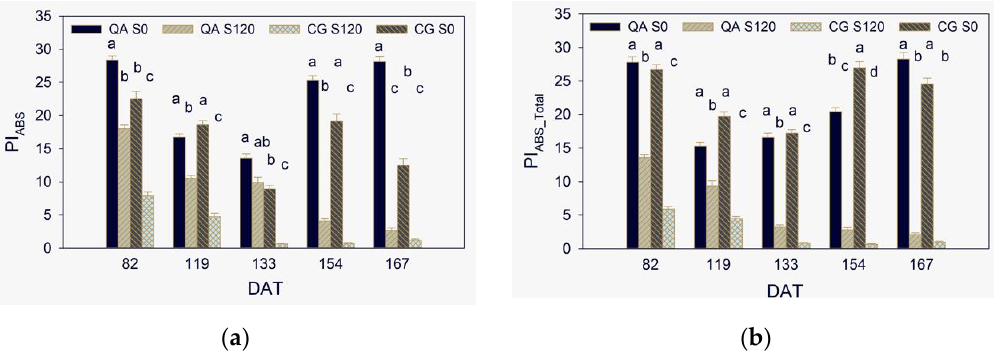
Figure 3. The two performance indexes on absorption basis, PI ABS ( a ) and PI ABS_total ( b ), from DAT 82 to DAT 167. Values are the means of 24 replicates. The vertical line on each bar represents the mean standard error. Within each DAT, values among the four G × S combinations with the same letter are not significantly different at p < 0.05.